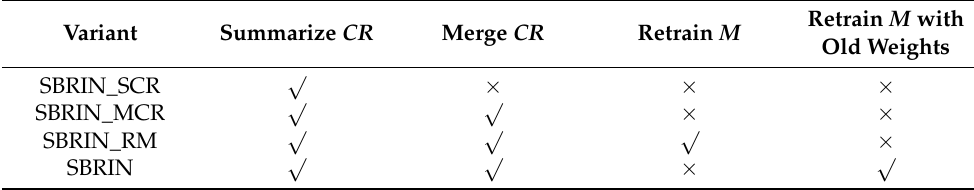
Table 4. SLBRIN Table 4. SLBRIN Variants.